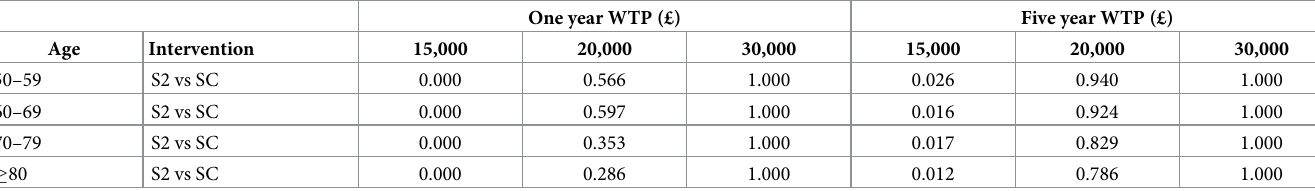
Table 9. Probability of cost-effectiveness at various WTP thresholds: One dose per annum.